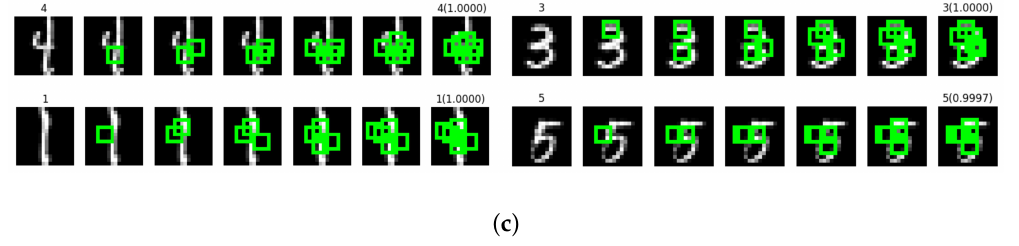
Figure 4. Visualization of the learned target policy π T by adversarial hard attention adaptation. The green boxes represents the locations selected by reinforcement learning agents at each time. For each sub-figure, the left two rows correspond to the actions (glimpses) taken by the source domain agent S , and the right two rows correspond to the actions (glimpses) taken by the target domain agent T . For both sides, the first column is the image to be recognized with its true label, and the last column shows the predicted label and its corresponding probability. ( a ) hard attention adaptation from SVHN to MNIST; ( b ) hard attention adaptation from MNIST to USPS; ( c ) hard attention adaptation from USPS to MNIST.